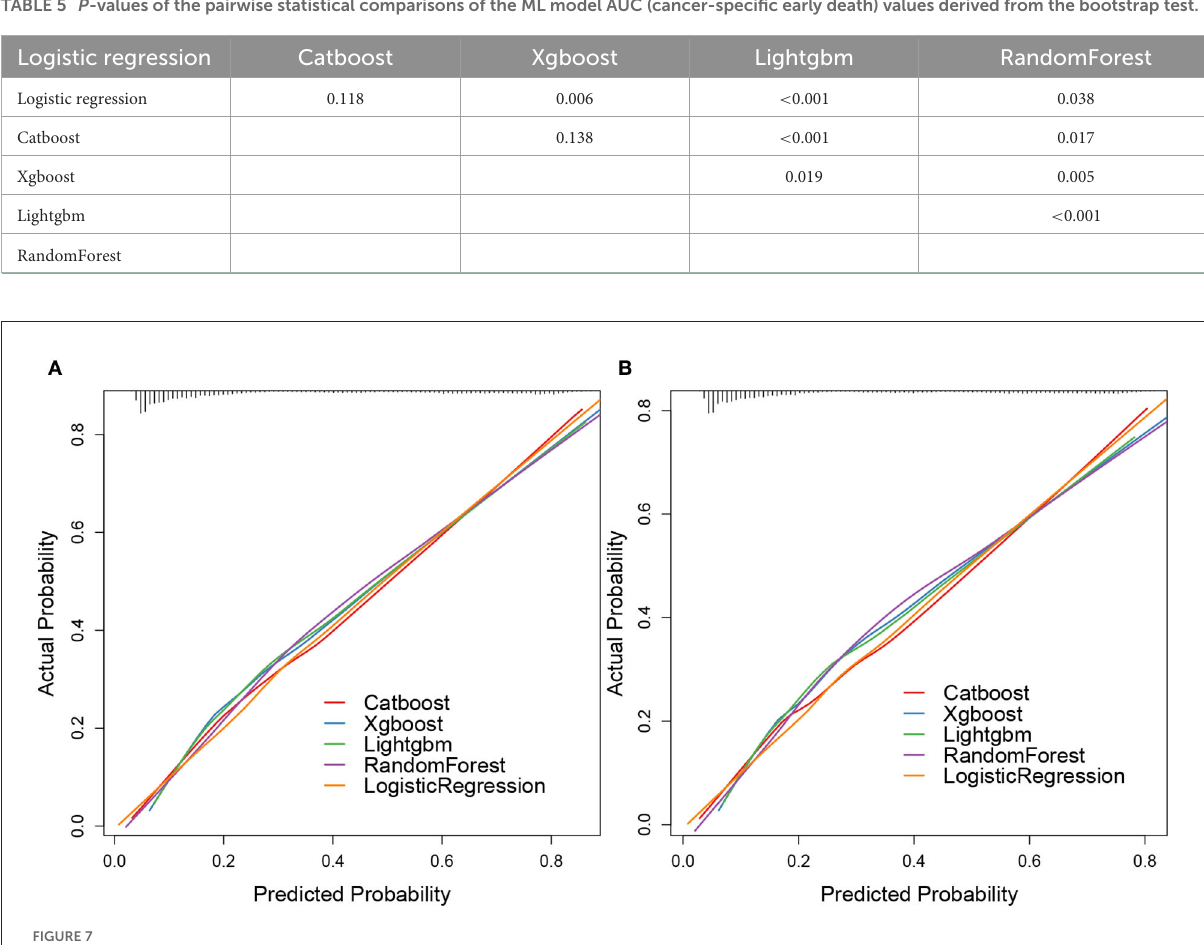
TABLE 5 P -values of the pairwise statistical comparisons of the ML model AUC (cancer-specific early death) values derived from the bootstrap